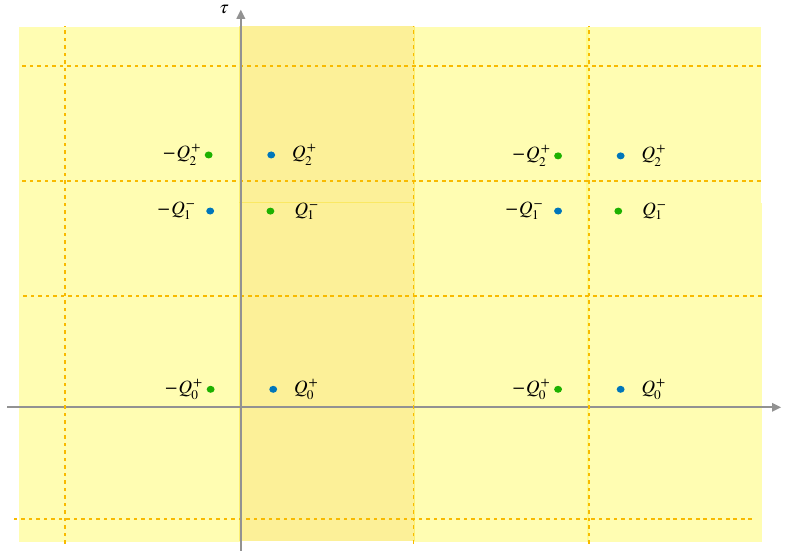
Figure 5: Distribution of charge images in the massless quench in a finite system with OBC. The physical strip corresponding to the one in Fig. 4 (right) is highlighted (light orange) for